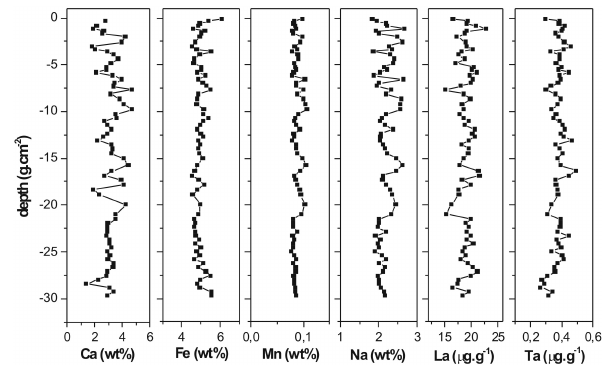
Fig. 7. Lake Tonˇcek sedimentary sequence. Selected major ele- ments and geochemical tracer concentration